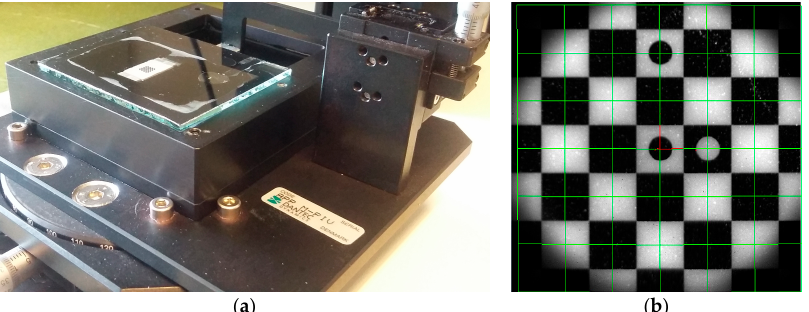
Figure 4. ( a ) Stereoscopic image calibration kit for µPIV. ( b ) Checkerboard calibration target with the assumed coordinate system (red) and metric calibration grid (green). Each tile is 500 µm wide.